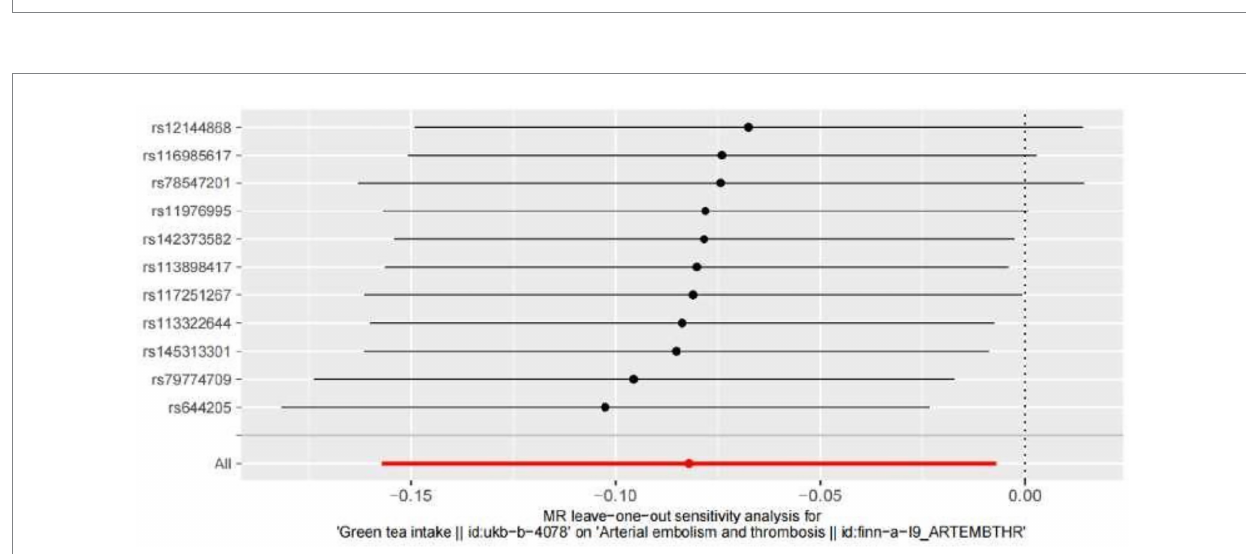
FIGURE 4 Funnel plots to visualize the overall heterogeneity of MR estimates for the effect of hypertension on the risk of ED. IVW indicates inverse-variance weighted, and MR indicates Mendelian randomization.